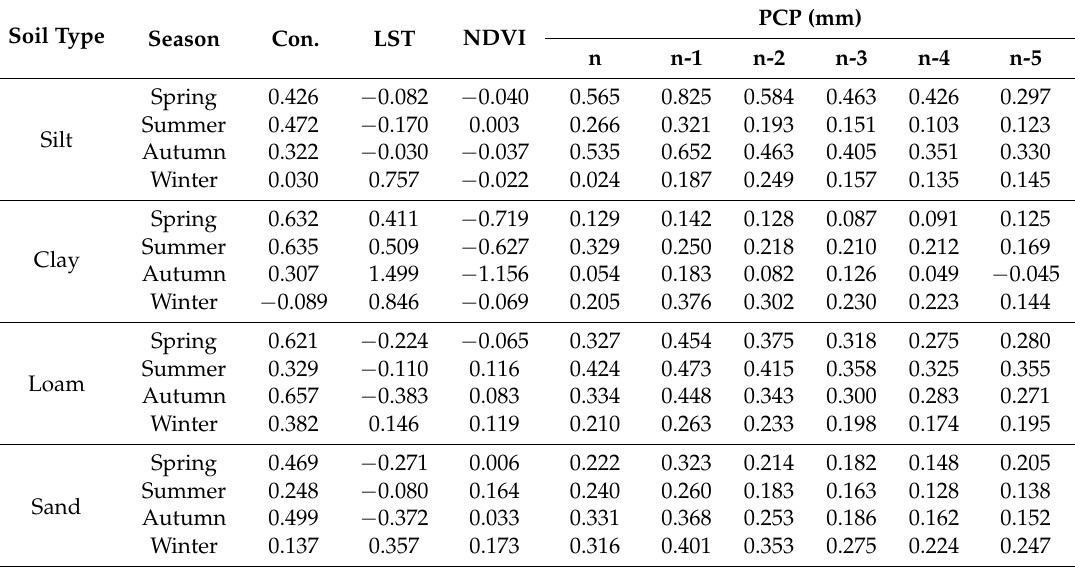
Table 7. Normalized regression coefficients in four seasons and for four soil